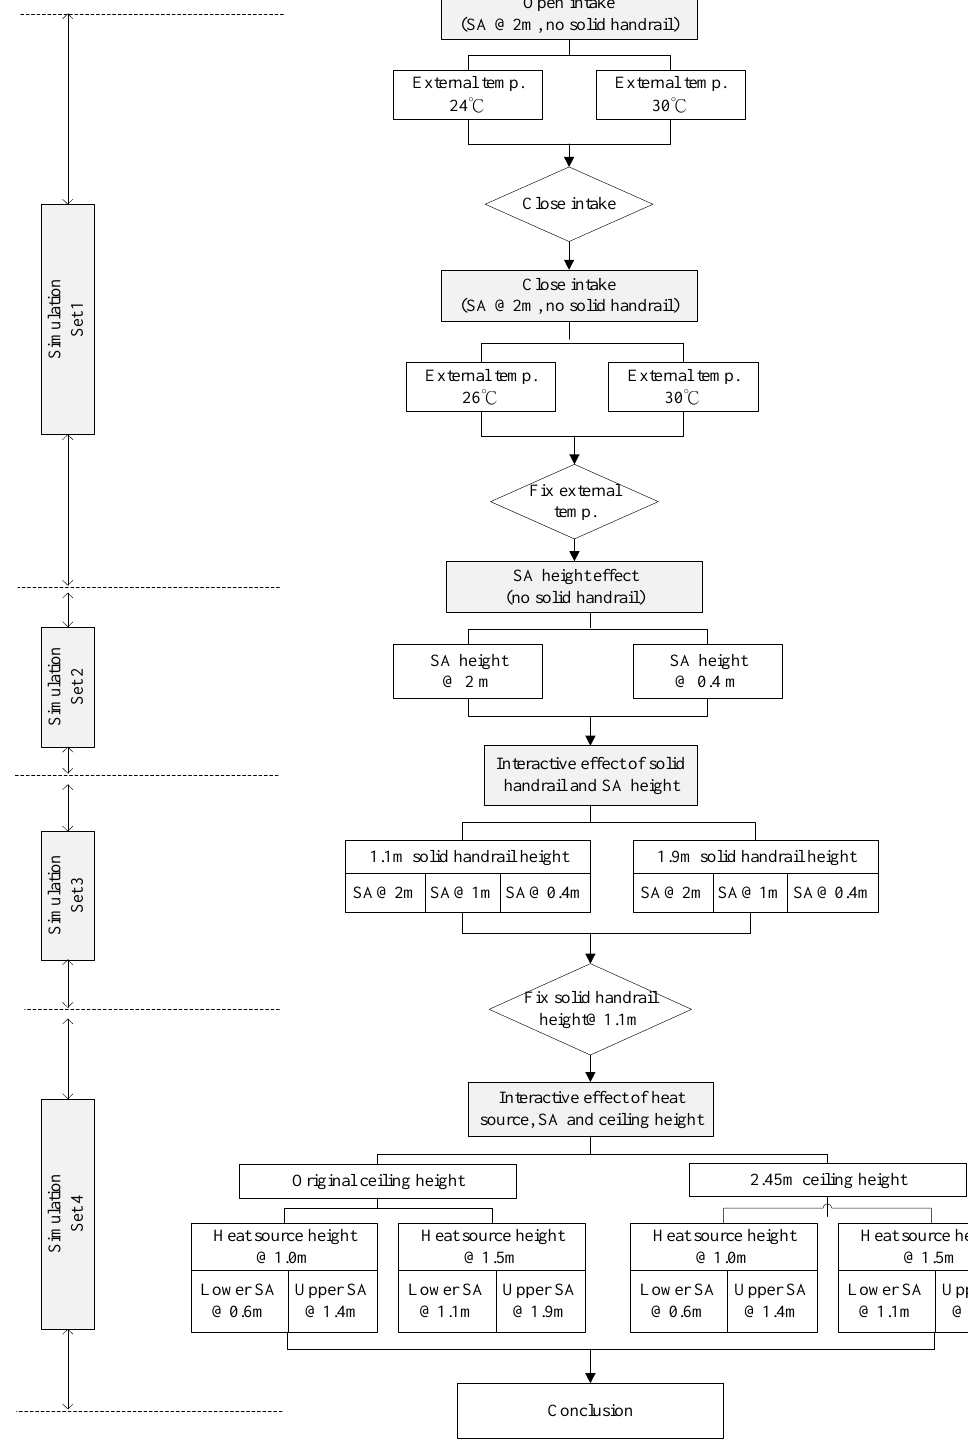
Figure 6. Research procedure.